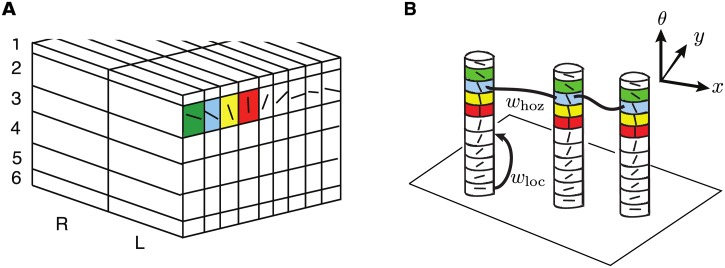
Schematic illustration of R
2 × S
1 model of V1.(a) Ice cube model of Hubel and Wiesel [59] showing cortical layers, orientation hypercolumns, and left(L)/right(R) ocular dominance columns. (b) Abstraction of superficial layers 2/3 as a collection of vertical cylinders (hypercolumns) that form a fibration of the plane. Patchy horizontal connections w
hoz are represented as links between the vertical cylinders. There are also local recurrent connections w
loc within each hypercolumn.